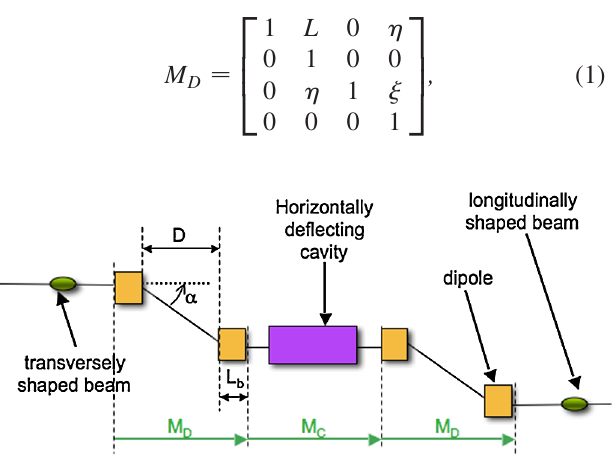
FIG. 1. Overview of the proposed technique to produce rela- tivistic electron bunch with arbitrary current